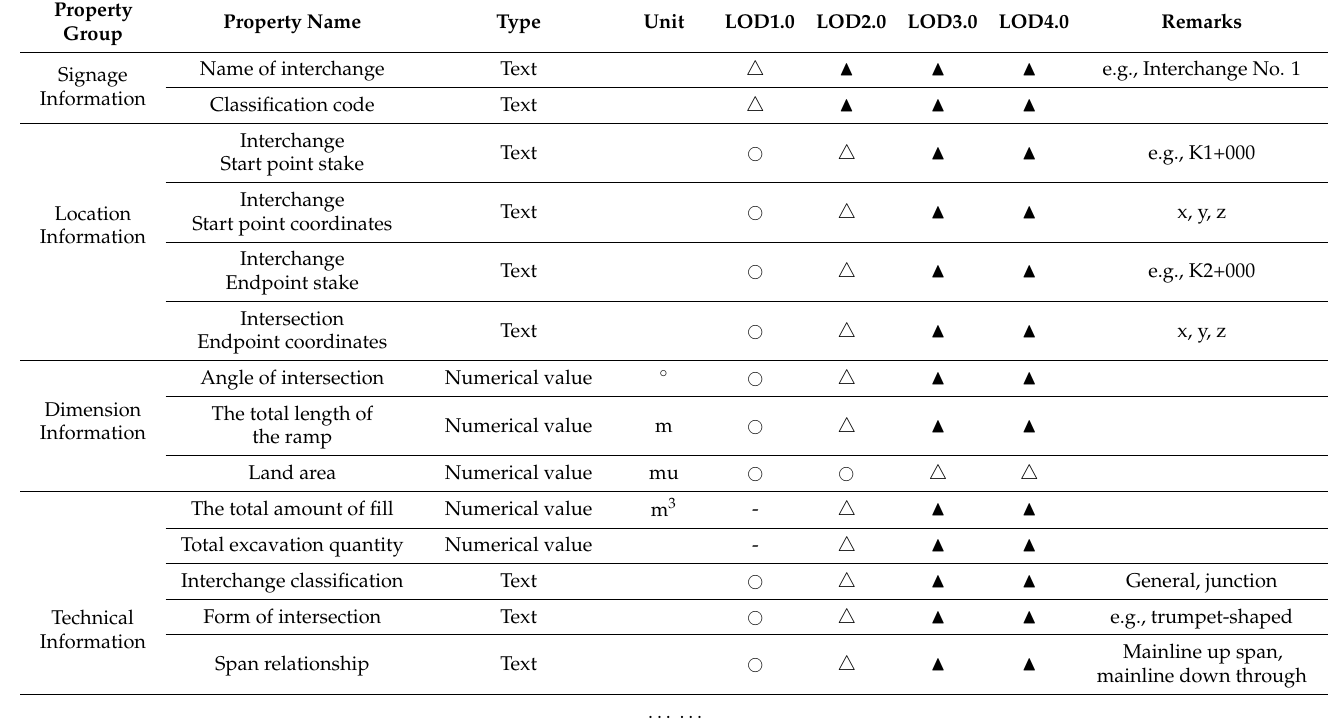
Table 8. Level of interchange BIM components’ general information.